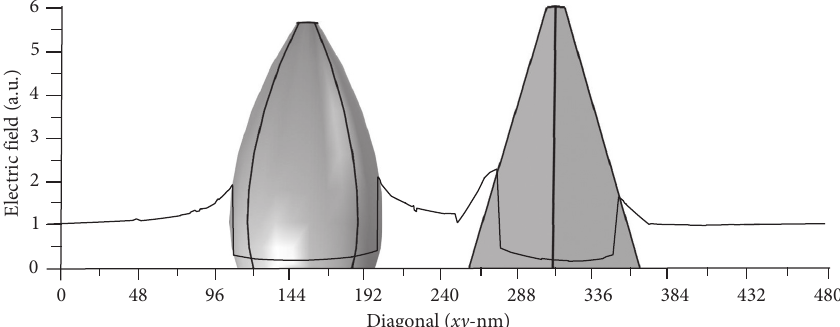
Figure 19: Plasmonic decay in the arrangement of nanoantennas for normal